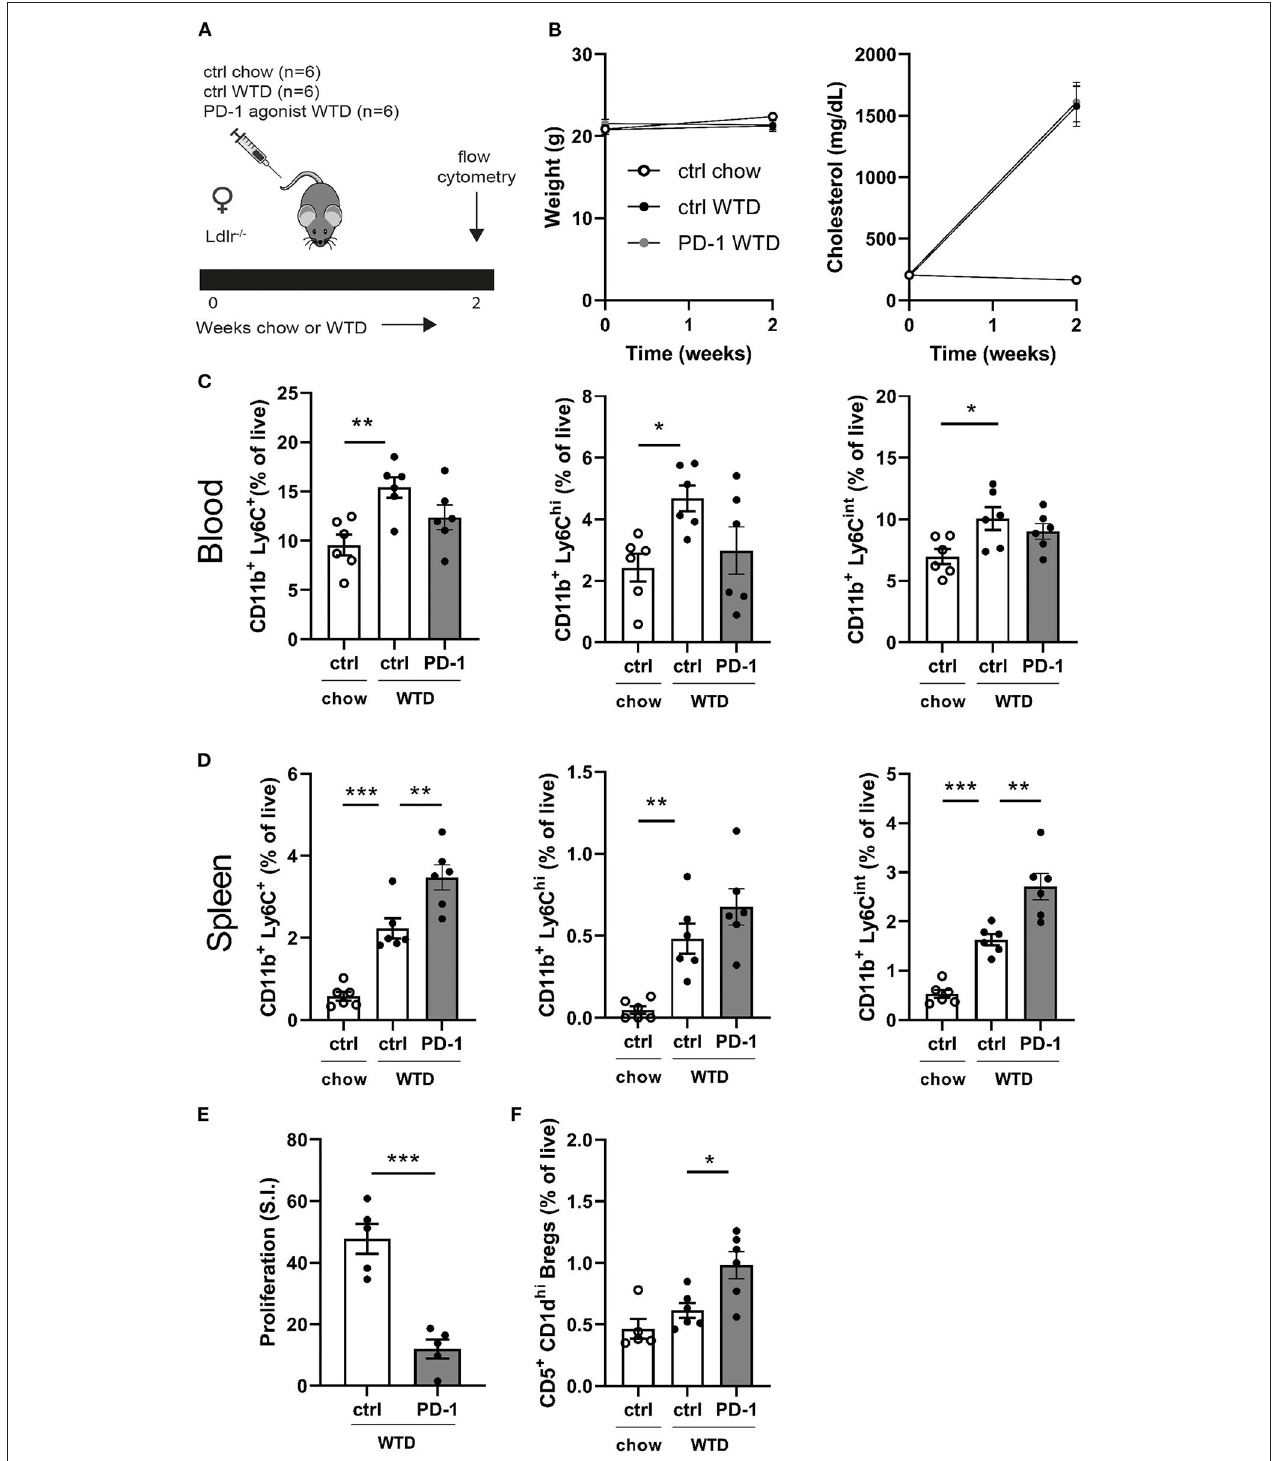
FIGURE 1 | Short term PD-1 stimulation alters monocyte levels and inhibits T cell proliferation. (A) Experimental setup. Ldlr − / − mice were fed a WTD or chow diet for 2 weeks while receiving an agonistic PD-1 antibody or control vehicle. (B) The weight and serum cholesterol levels were assessed before and after treatment. (C) Peripheral blood and (D) splenic monocyte percentages were measured by flow cytometry. (E) Proliferation of splenocytes after 3 days of stimulation with anti-CD3 and anti-CD28 measured by [3H]thymidine labeling ( n = 5/group). (F) Regulatory B cells in peripheral blood were measured by flow cytometry. Data are displayed as mean ± SEM. Statistics was performed using one-way ANOVA, with post-hoc comparison using Dunnett’s multiple comparisons test, comparing control chow and PD-1 WTD groups to the control WTD group. P ≤ 0.05 are considered significant. * p ≤ 0.05, ** p ≤ 0.01, and *** p ≤ 0.001.